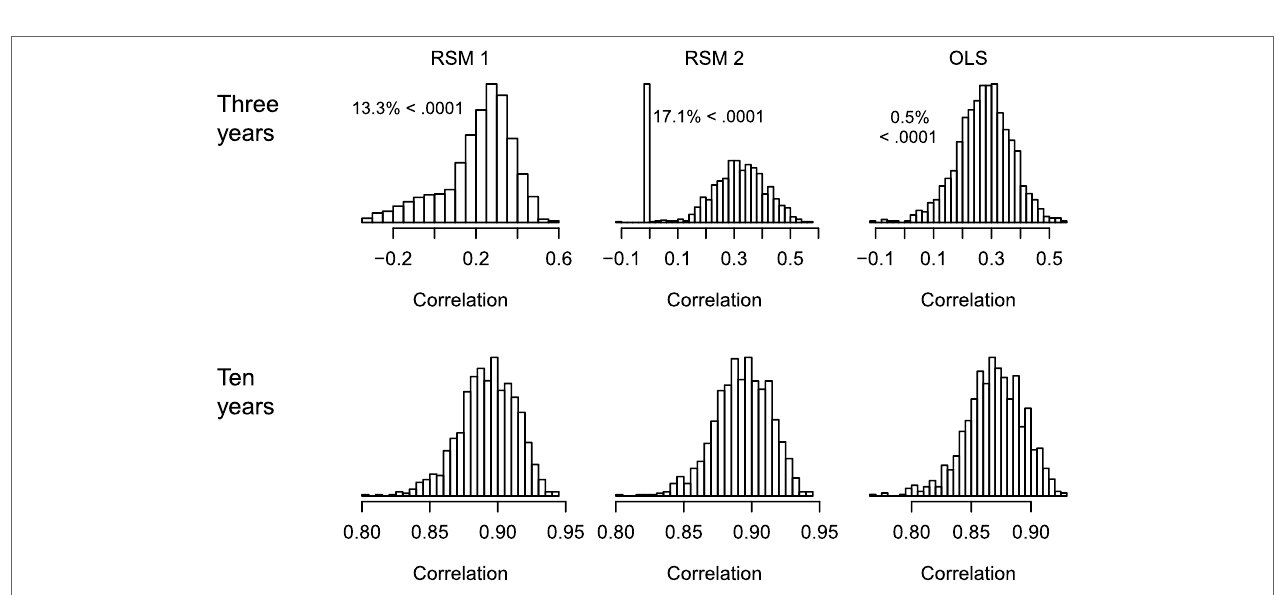
FIGURe 4 | Histograms for the SD of the slope estimates for the different estimation methods when there are 3 and 10 years of data. Simulation 1 (normally distributed linear relationships). RSM 1 and RSM 2 refer to estimating the correlation between the random variables (1) and fixing it at zero